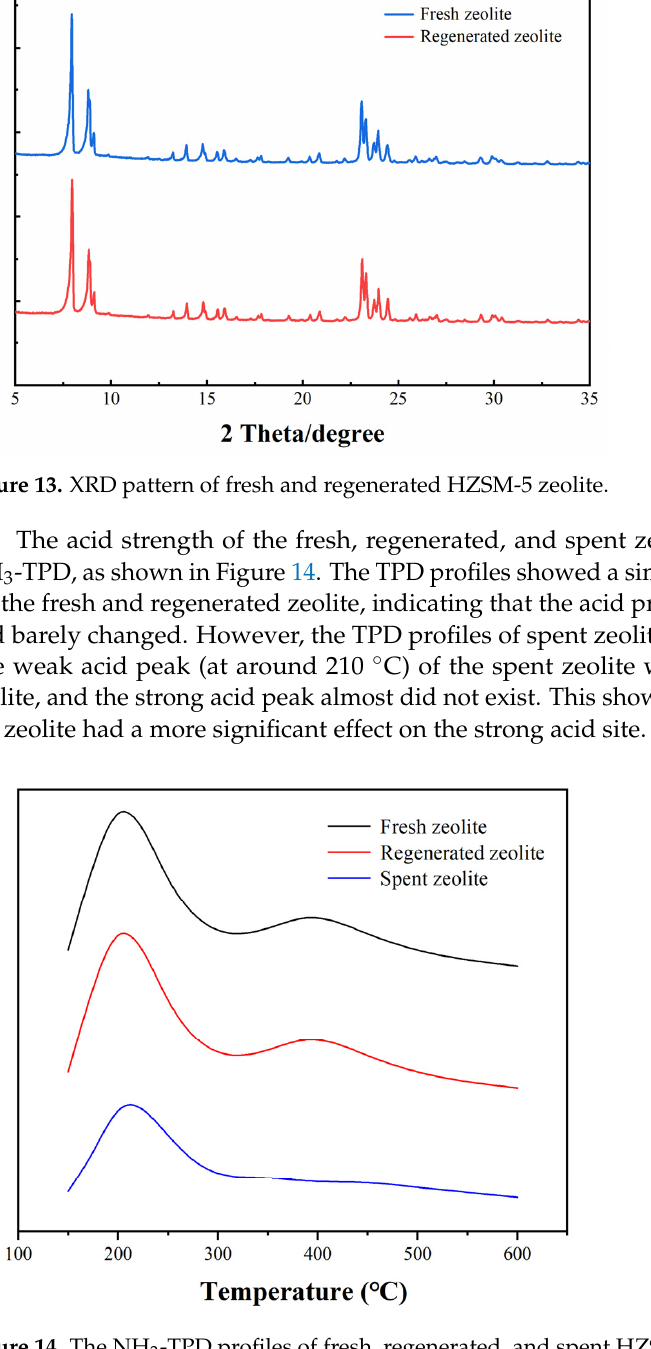
Table 4. Textural properties of the